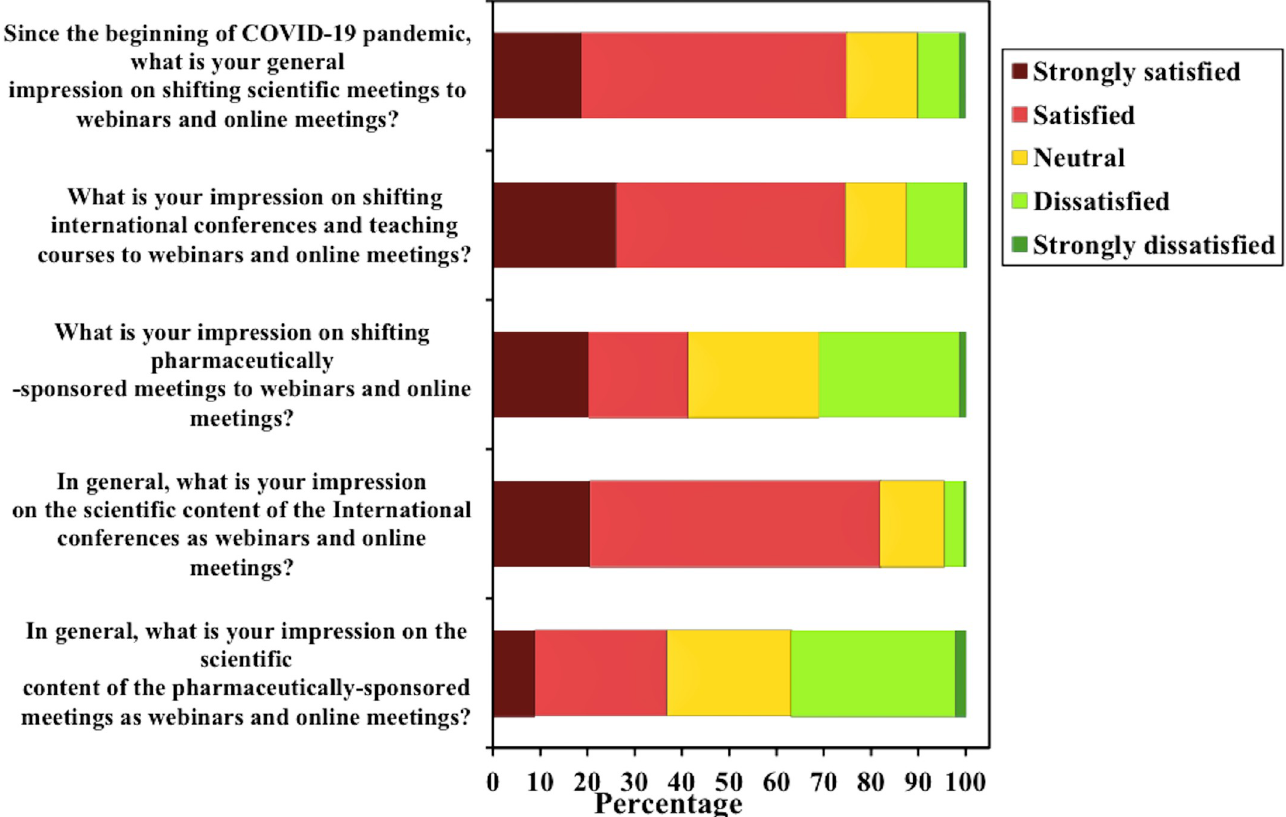
Fig 1. Stacked bar chart of Likert questions. The figure shows 5bar charts describing the impression of physicians towards shifting scientific activities into online format, the impression differences between international conferences and pharmaceutically-sponsored activities, and the perception of the scientific content of these activities during the